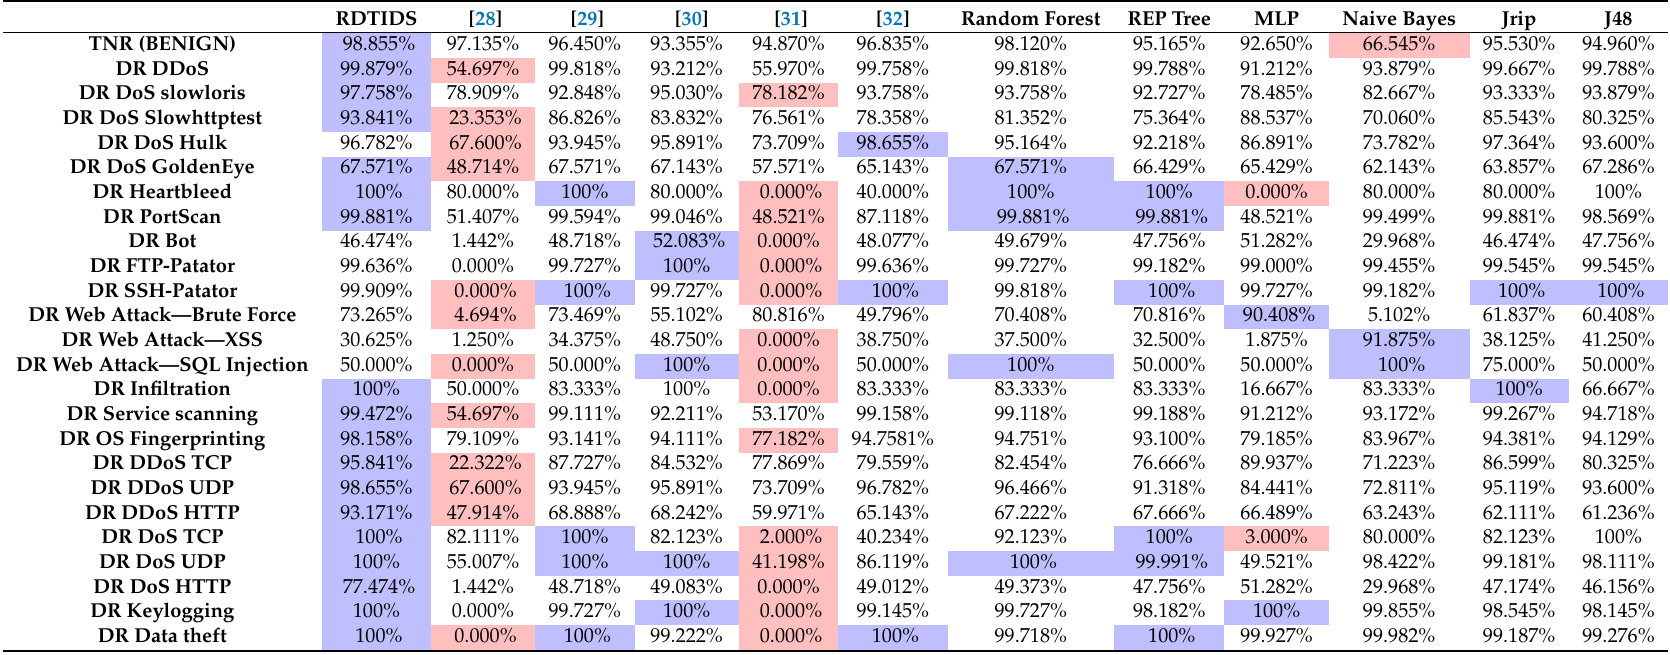
Table 5. Performance of RDTIDS system and other classifiers relative to the different attack type and